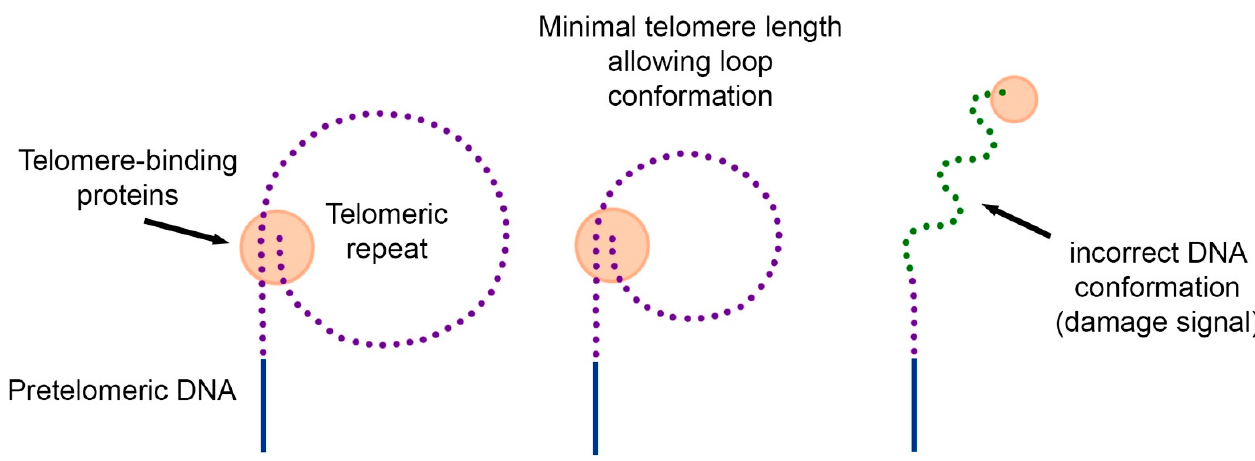
Figure 2. The hypothesis of the loop structure of telomeres. Telomeric DNA together with telomere-binding proteins can form loops. Due to the restriction of free rotation of DNA and interaction with various proteins, the DNA in the loop has a strained conformation. When telomeric DNA is shortened, there comes a point when the length of the telomeric repeat does not allow the loop to form. The telomeric end of the DNA acquires a free conformation, which is perceived by the cell as a signal of damage. As a result, the mechanism of replicative cell senescence is trig- gered.